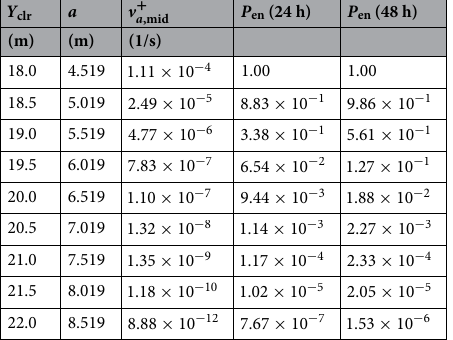
Table 3. Probability of encroachment at mid-span under V 10 = 30